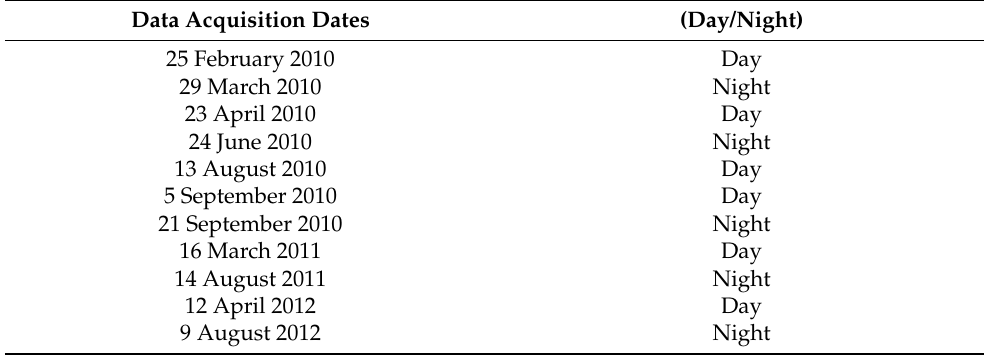
Table 2. Satellite images considered for the